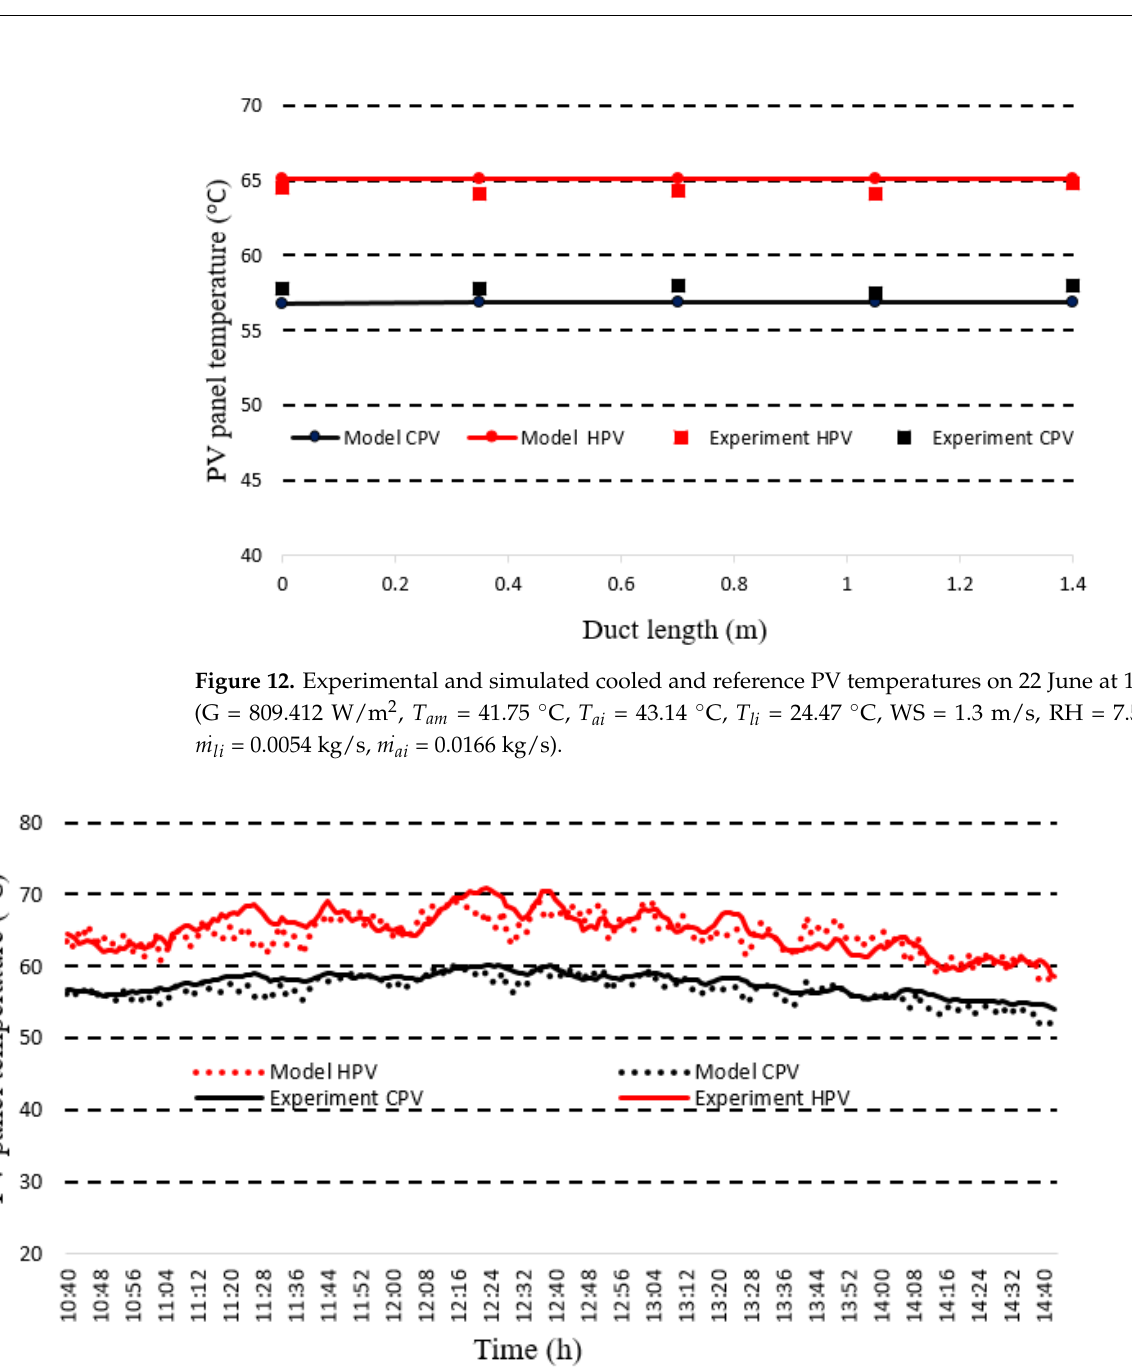
Figure 13. Experimental and simulated cooled and reference PV temperatures on 20 June.